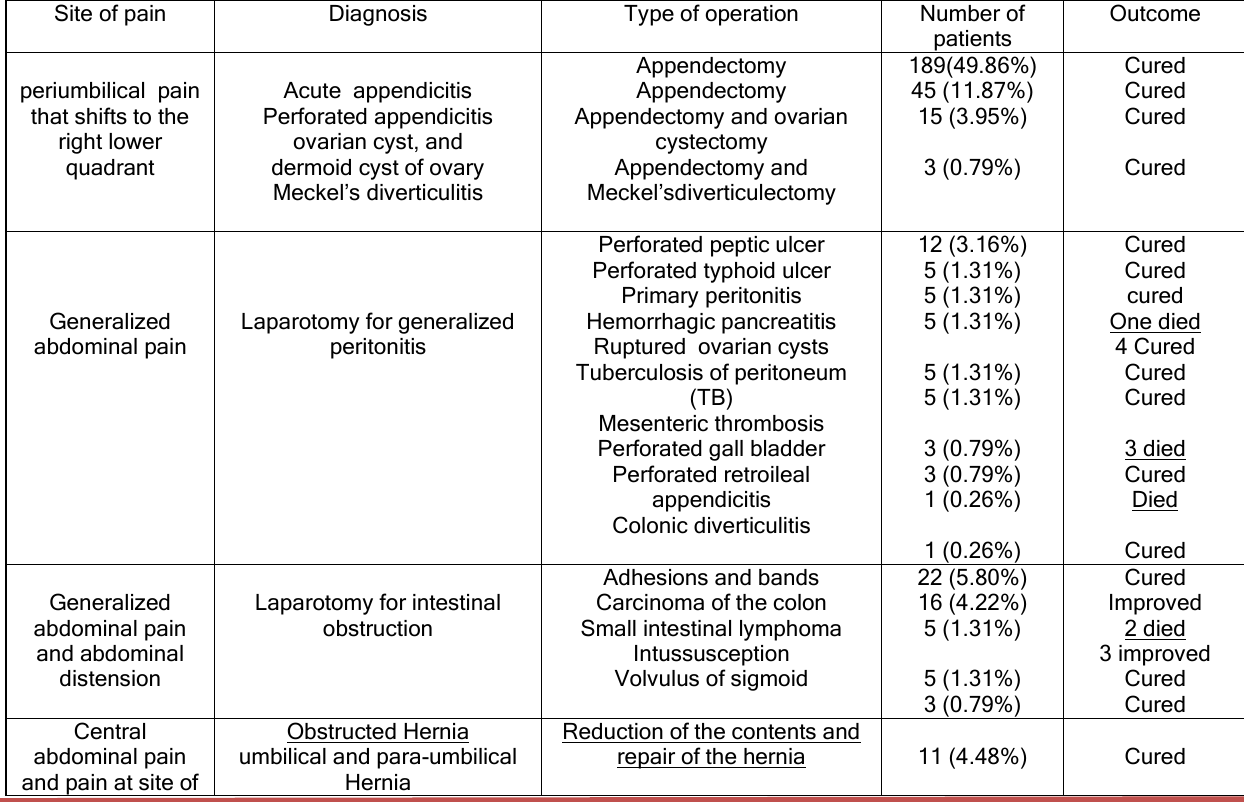
Table (2): Shows theOperative findings in (Group B)